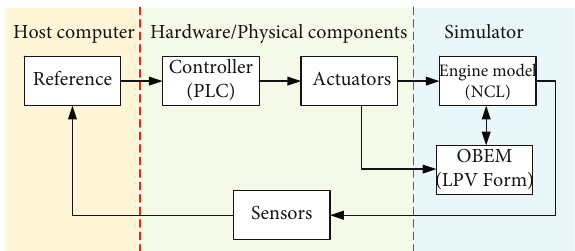
Figure 11: Structure of the semiphysical experimental platform (it is reproduced from